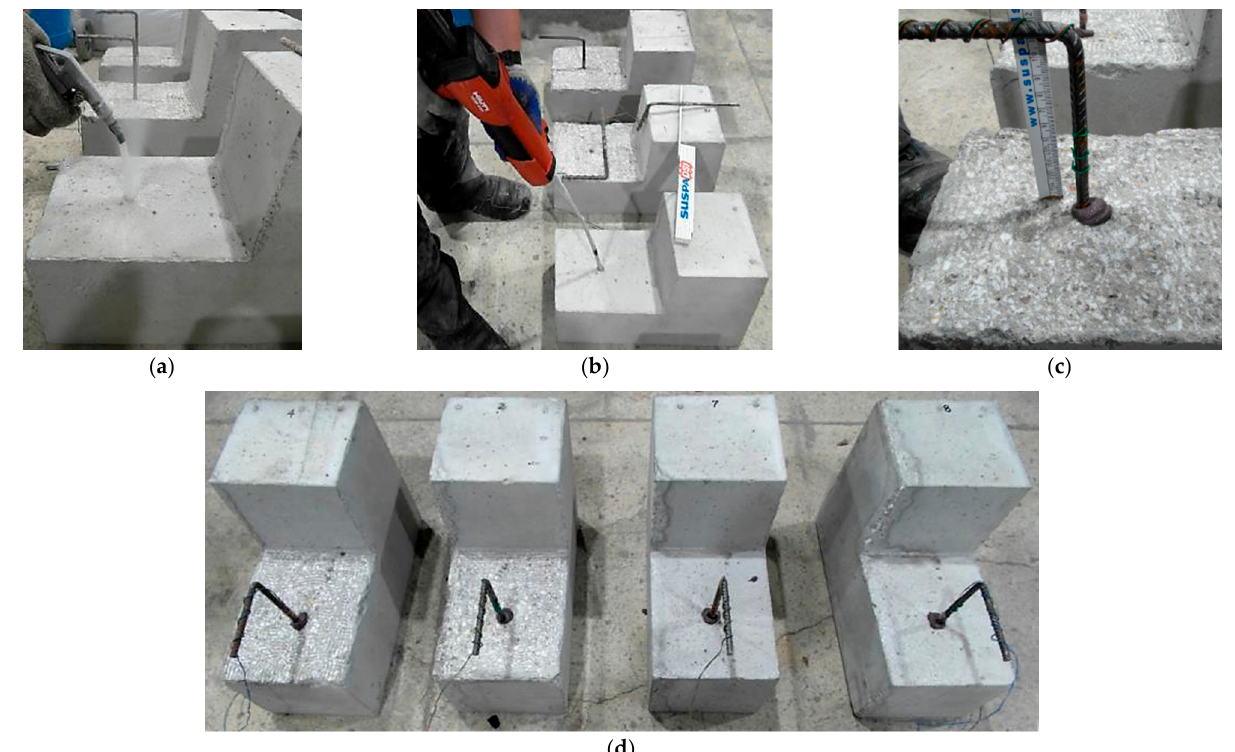
Figure 9. Subsequent stages of preparation of the interface reinforcement: ( a ) Cleaning of bored holes with compressed air, ( b ) application of the adhesive resin, ( c ) installing of the deformed rebars, ( d ) curing of the resin.